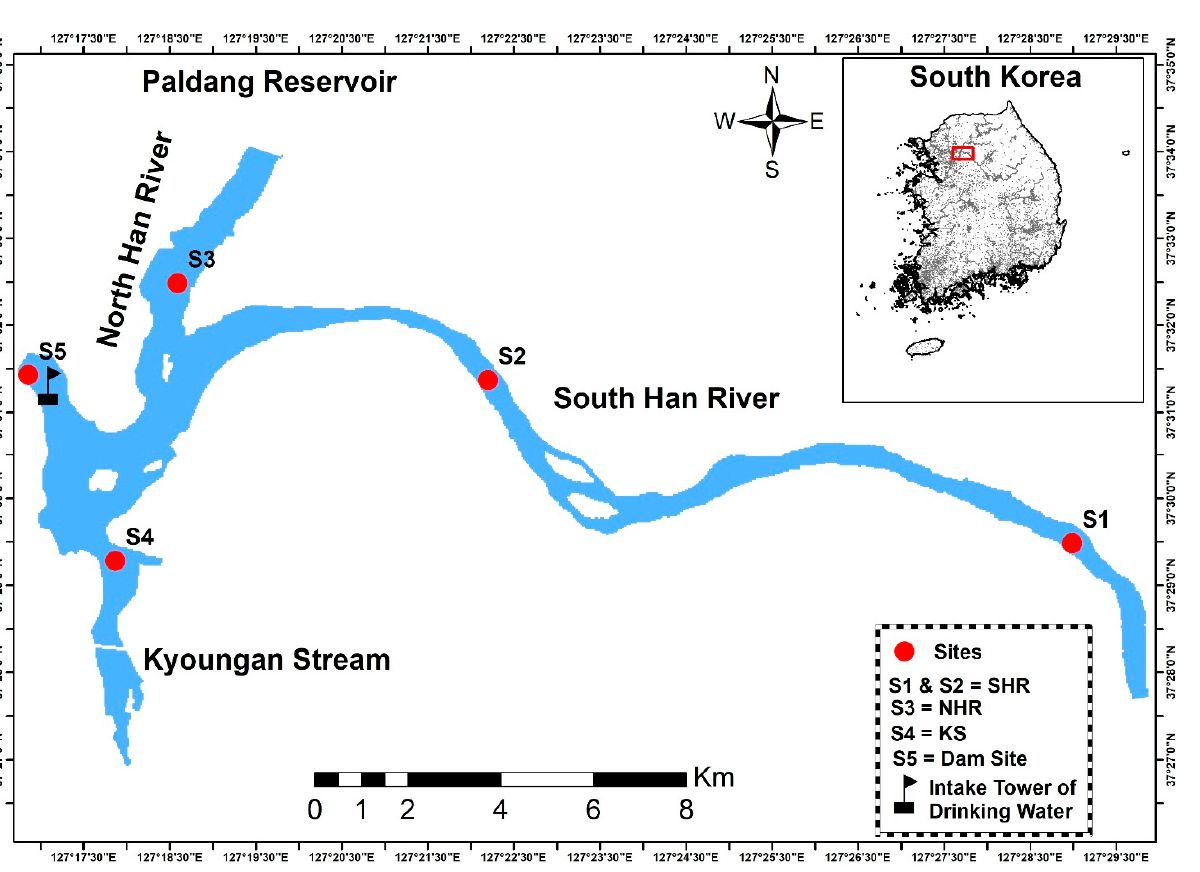
Figure 1. The map showing the study sites of Paldang Reservoir.